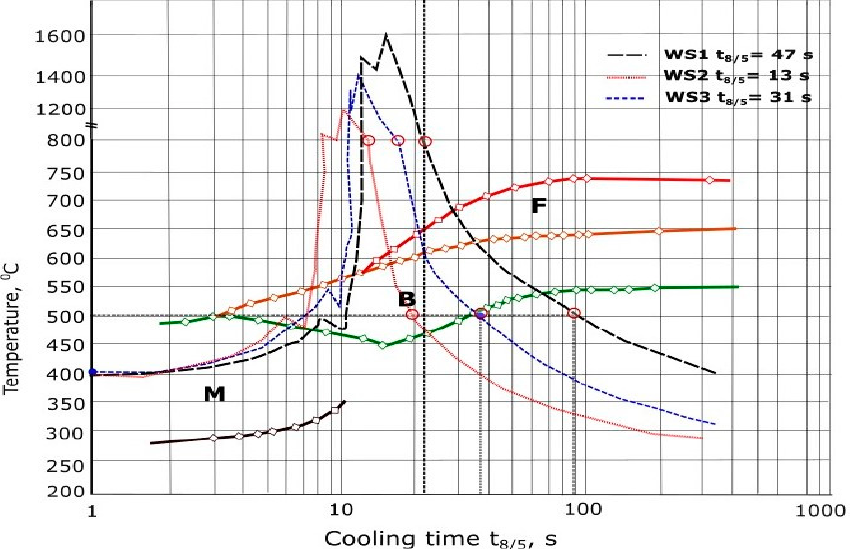
Figure 4. The cooling continuous temperature (CCT) diagram of S700MC (obtained using JMatPro software), including the cooling time curve values of the three heat input parameters.